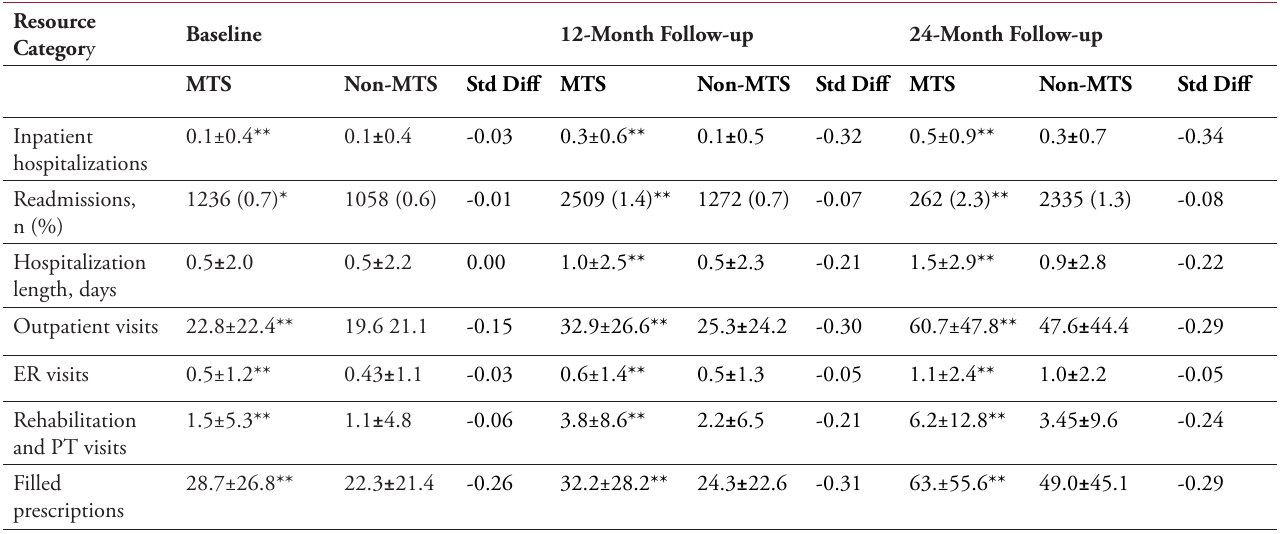
Table 3. Healthcare Resource Utilization at Baseline and 12- and 24-Month Follow-up in Propensity Score-Matched Cohorts